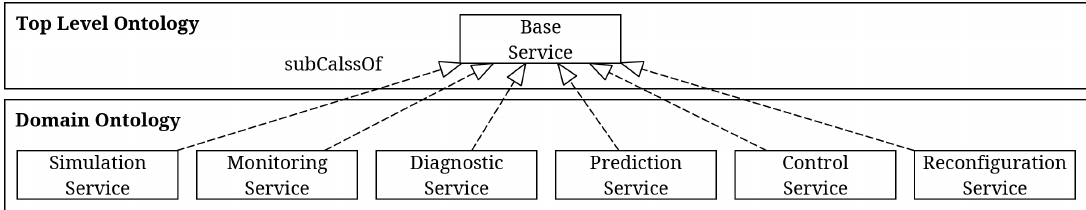
Figure 3. Top Level and Domain Ontology